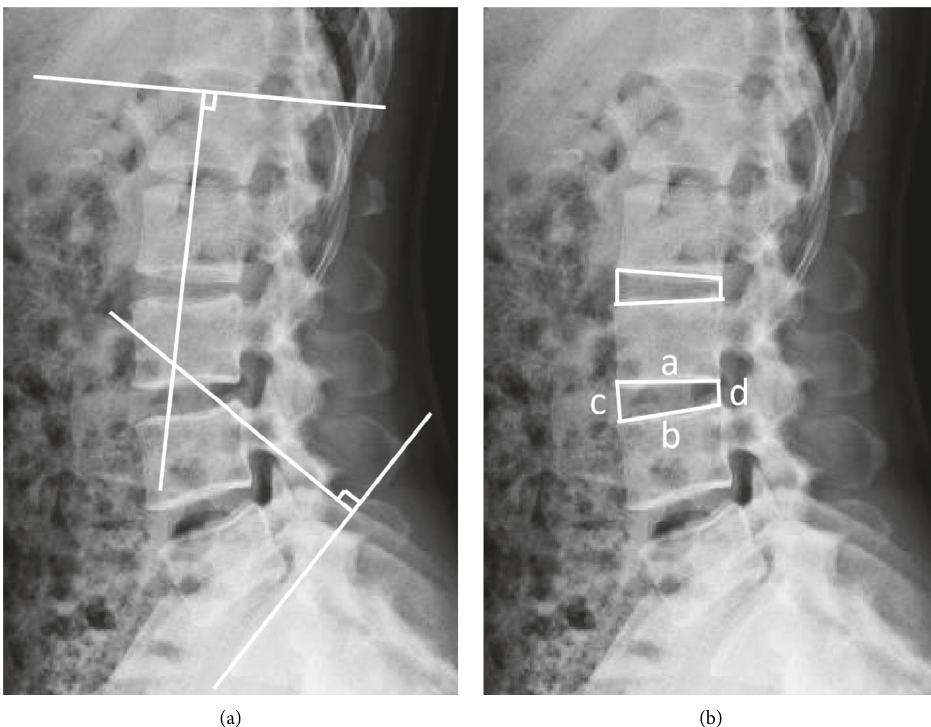
Figure 1: Lumbar lordosis (LL) and lumbar disc height index (DHI) measurements. (a) LL: the angle between the tangent line of the upper endplate of the L1 vertebral body and S1 vertebral body in the lateral lumbar spine. (b) DHI: (intervertebral leading-edge height+posterior edge height)/(intervertebral upper body width +lower body width) ∗ 100%, where a is the intervertebral upper body width, b is the intervertebral lower body width, c is the intervertebral anterior edge height, and d is the intervertebral posterior edge